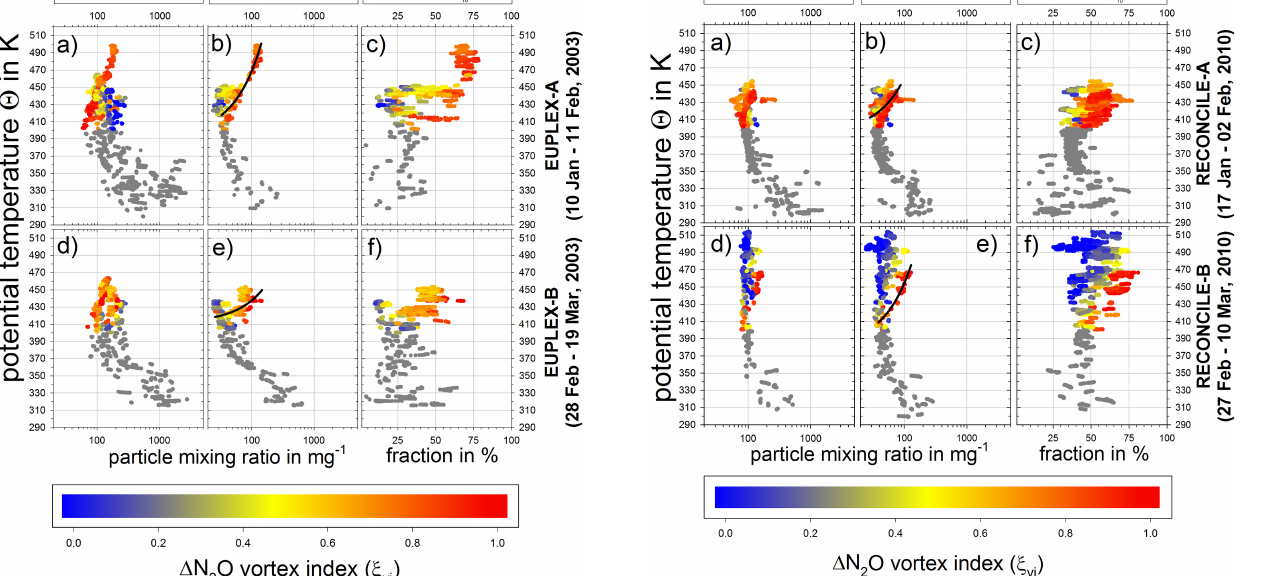
Figure 2. Vertical distribution of particle mixing ratio N 10 (left col- umn), N 10 nv (mid column) and resulting fraction f of non-volatile particles (right column) versus the potential temperature (cid:50) for the EUPLEX campaign in 2003. Data are additionally subdivided (cf. Sect. 3) in period A (January–February 2003) and period B (Febru- ary–March 2003). Data points for (cid:50) above 400K are color-coded according to (cid:49) N 2 O vortex index ξ vi . For (cid:50) below 400K, data points are left in gray as inside or outside vortex apportioning is not unambiguous (cf. Sect. 2). Black lines indicate a regression over those data points which fulfill the inside-vortex criterion (Sect. 2).